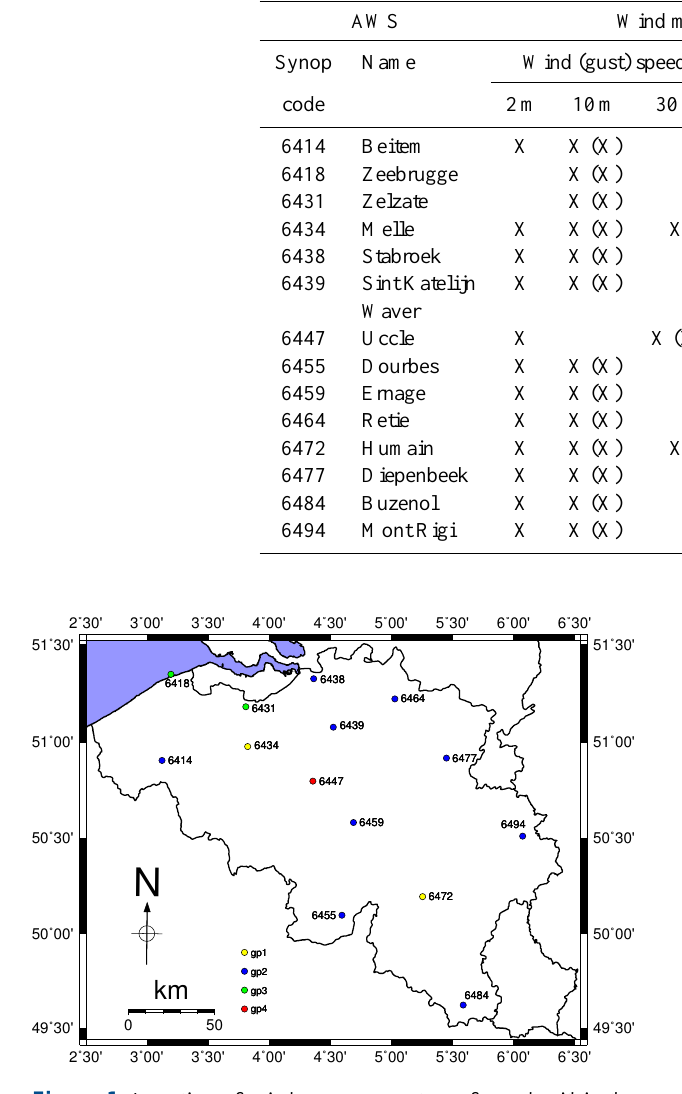
Figure 1. Location of wind measurements performed within the RMI’s AWS network and the associated QC groups (see Table 1 for QC group